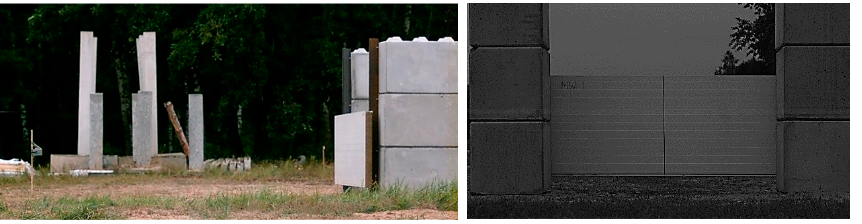
Figure 7. Variation of the overpressure Δ p r in MPa on the front surface of a sandwich panel. ( a ) Front view. ( b ) Cross- section A-A view.